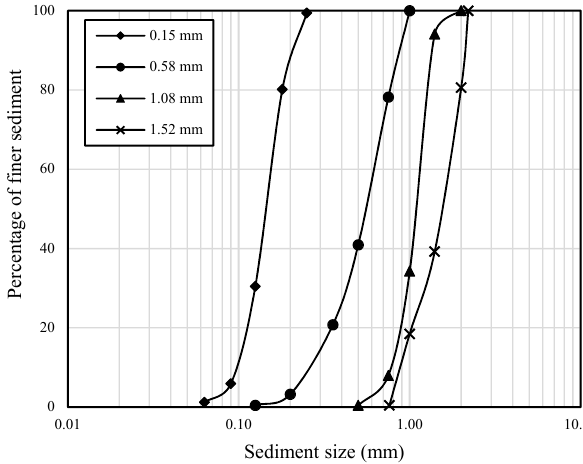
Figure 2. Granulometric curve of sediment. Table 1. Sediment characteristics. d : median diameter, s : relative mass density, 𝜎 (cid:3034) : geometric standard deviation of sediment particles.